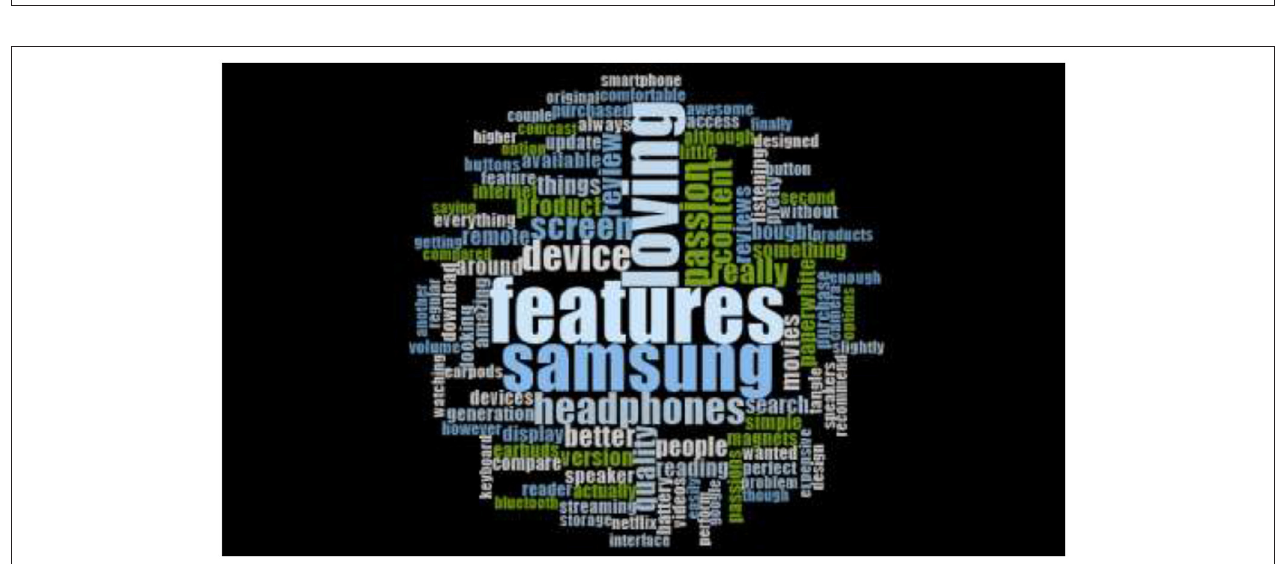
FIGURE 4 | Pakistani consumer’s sentiments about Samsung galaxy (Tweets Years 2017–2018).